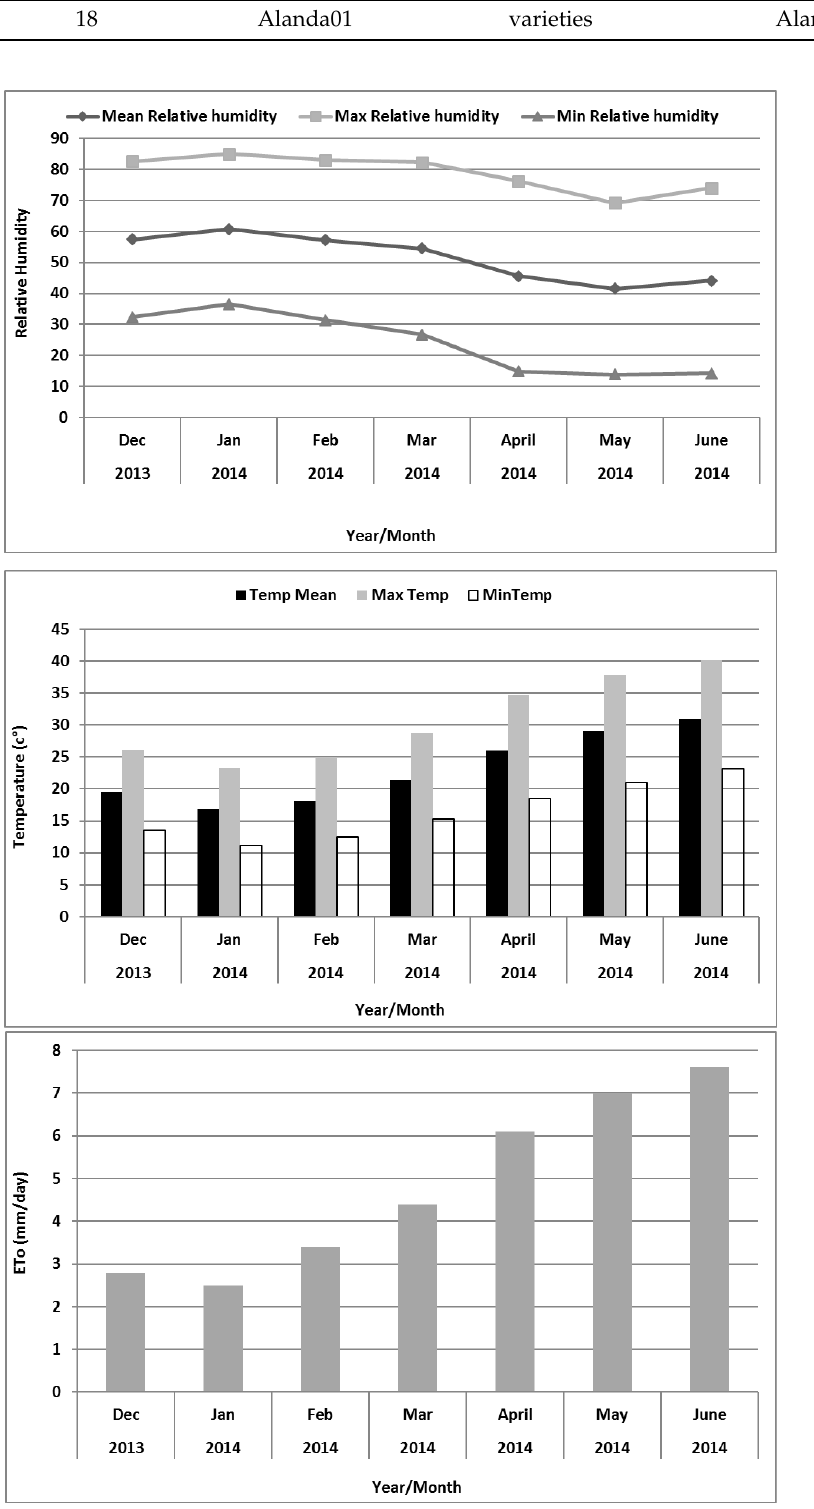
Figure 1. Monthly average values of mean (T mean), maximum (T maxi), and minimum (T min) air temperature and reference evapotranspiration (ETo) in the ICBA weather station, Dubai, UAE from December 2013 to June 2014.